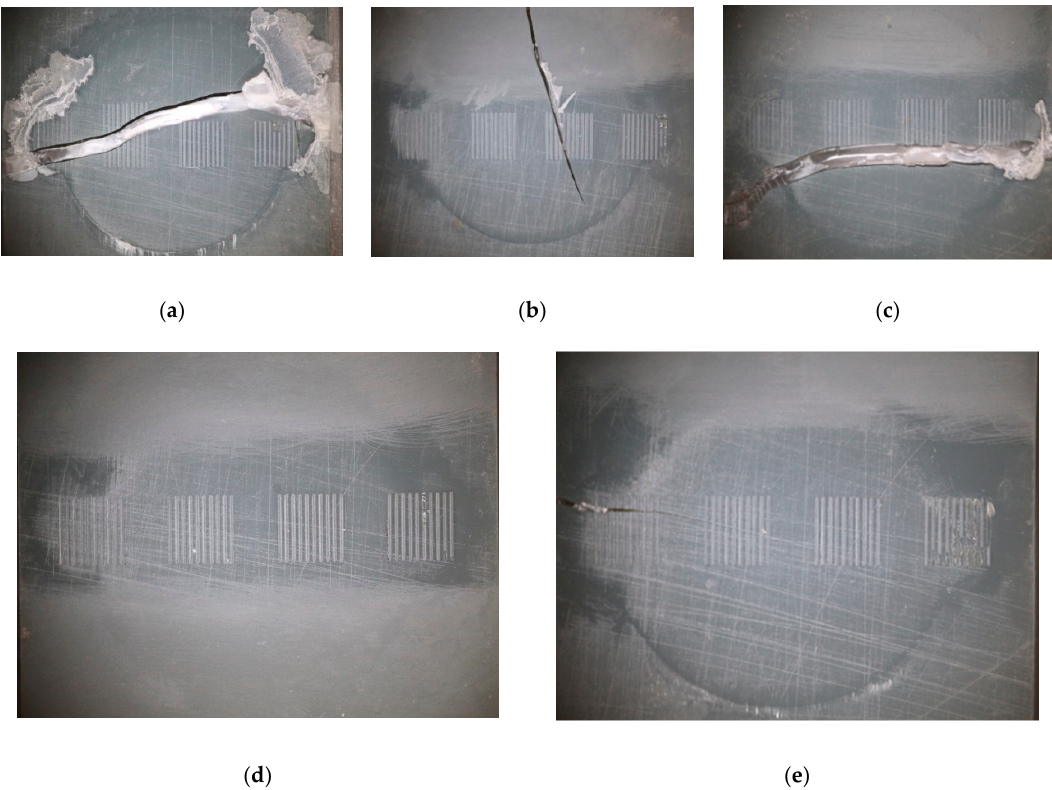
Figure 8. Images of tooling inserts: ( a ) Tool 1 after 36 shots, ( b ) Tool 2 after 16 shots, ( c ) Tool 3 after 29 shots, ( d ) Tool 4 after 60 shots (not cracked), and ( e ) Tool 5 after 78 shots.